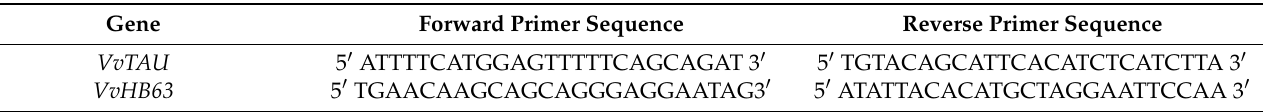
Table 1. Oligonucleotide primers used for PCR amplification of transcription templates. Gene Forward Primer